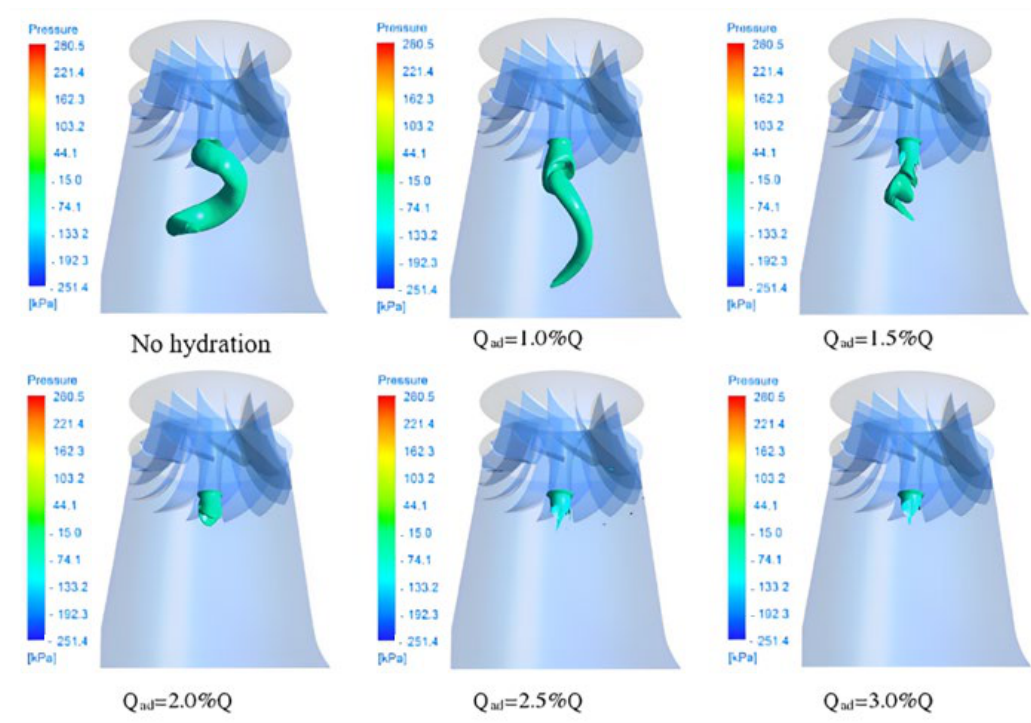
Figure 26. Draft tube vortex rope in partial load condition [38].